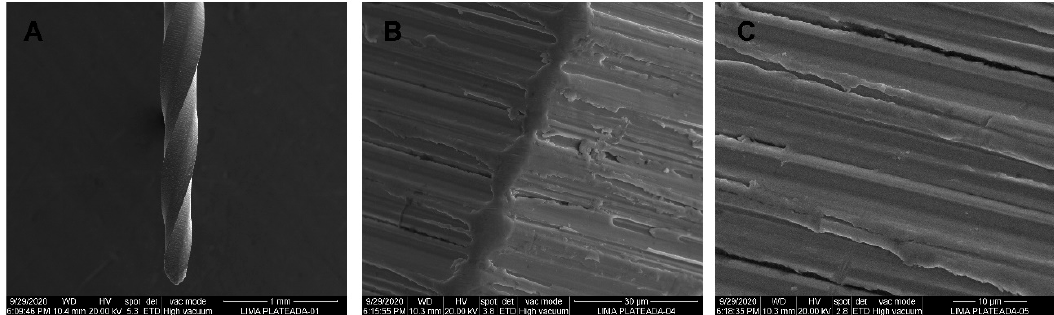
Figure 7. SEM images of NiTi alloy ProTaper Universal (PTU) endodontic rotary files at ( A ) 100×, ( B ) 3600×, and ( C ) 6500×.